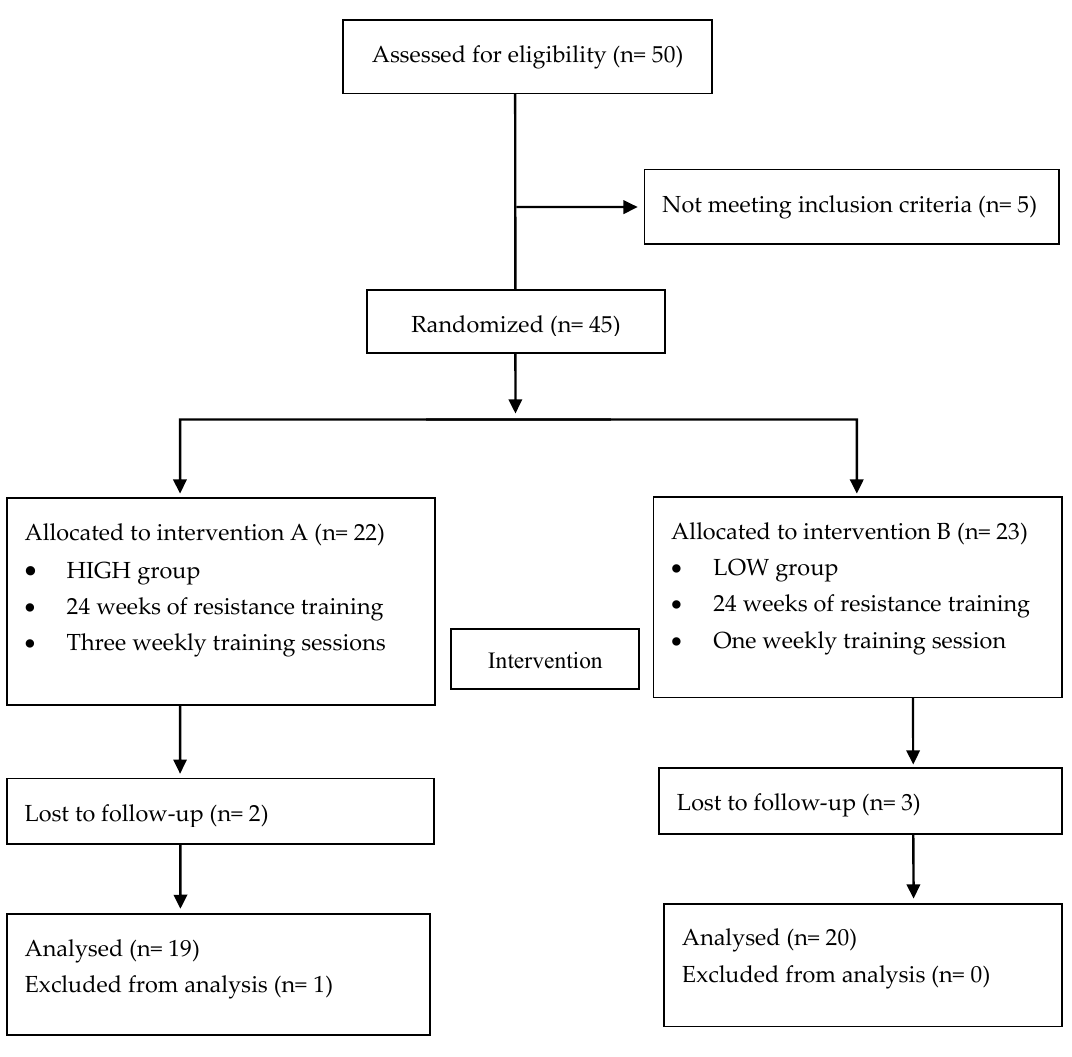
Figure 1. Flow chart.